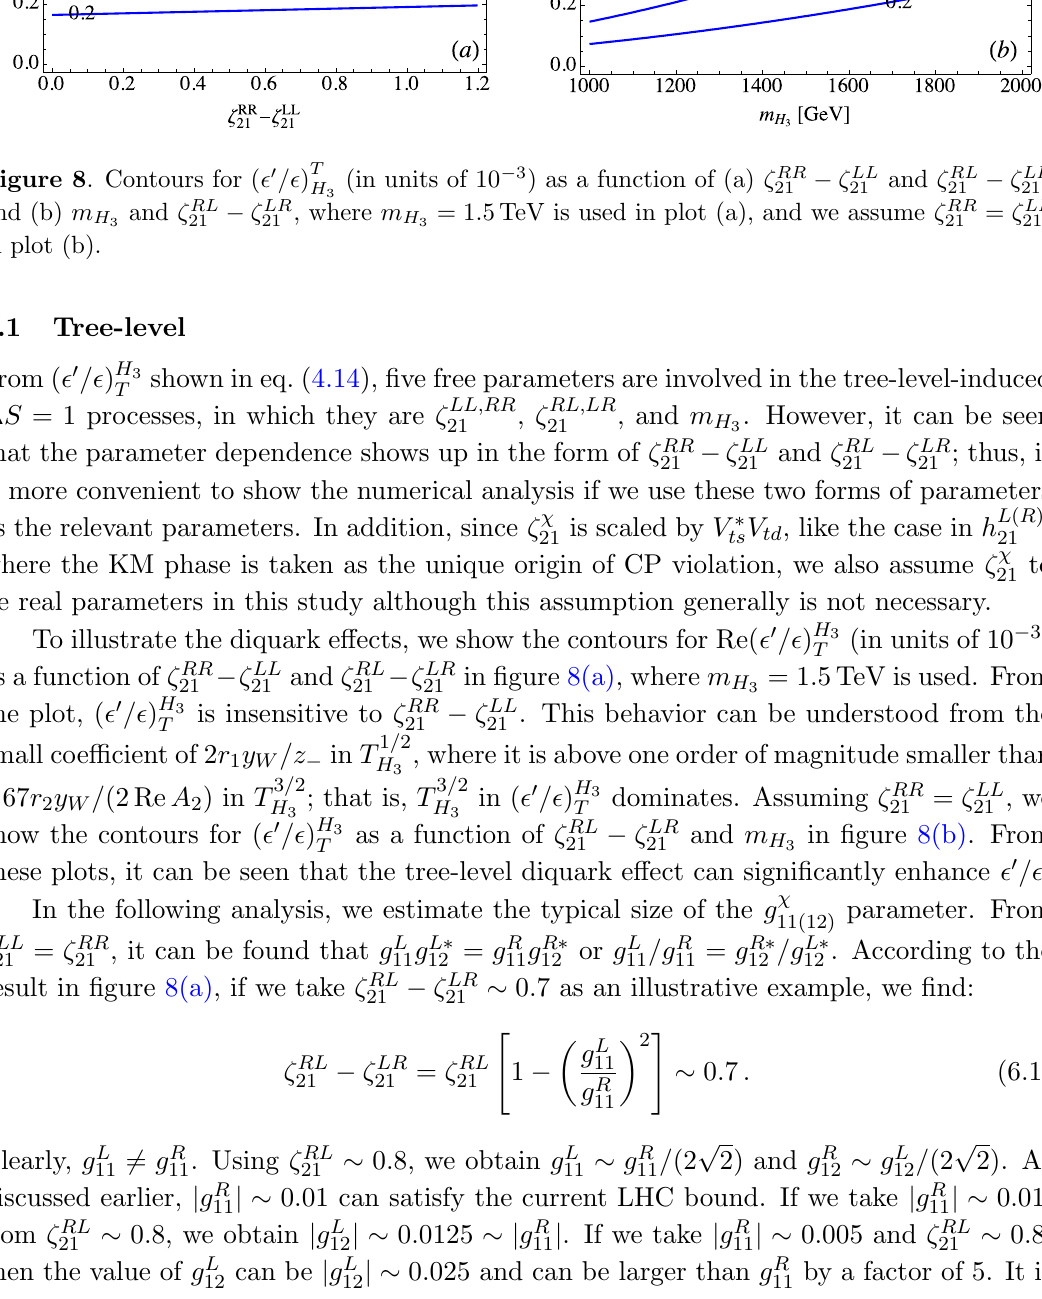
(cid:0) (cid:16) LL (cid:0) (cid:16) LR and (cid:16) RL 21 21 21 21 = (cid:16) LL 21 21